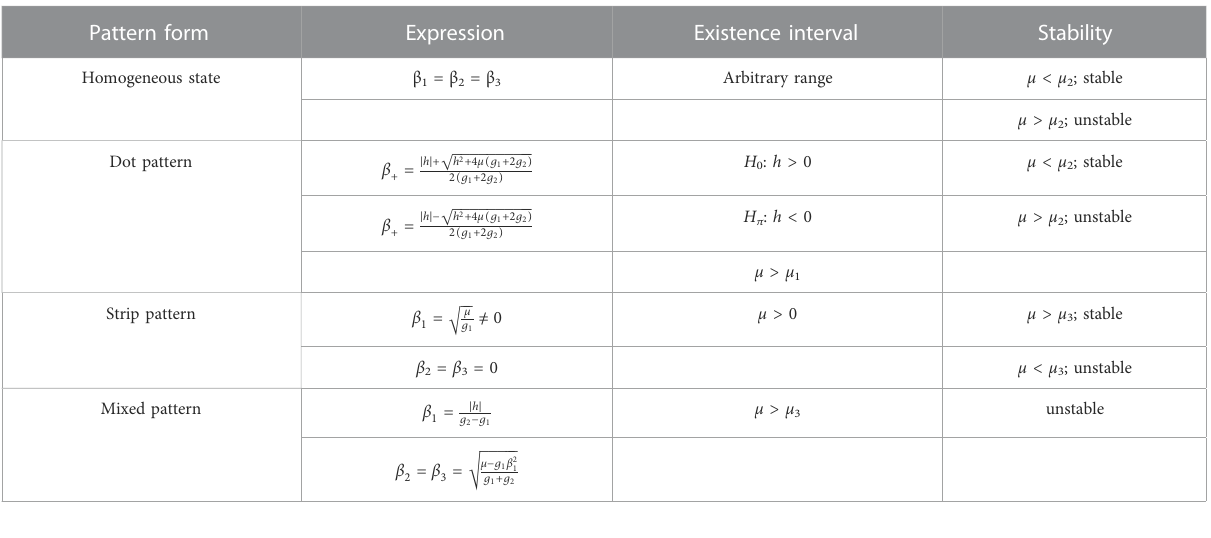
TABLE 2 Equation of different orders of ε .